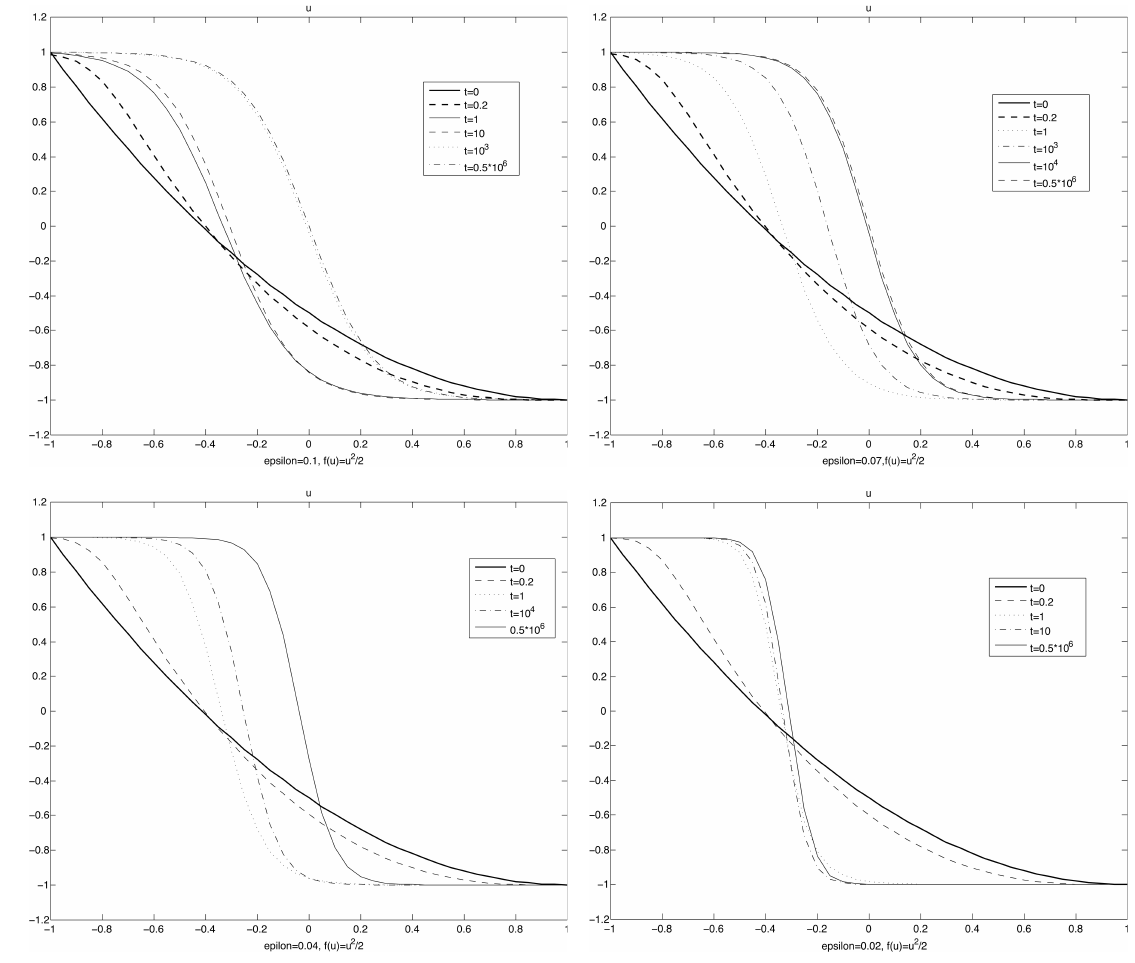
Figure 1. The interface profiles for different choices of the parameter ε and for f ( u ) = u 2 / 2.